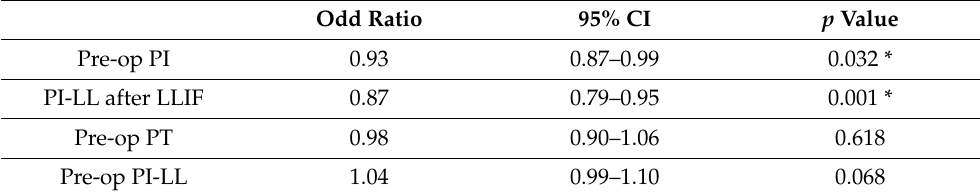
Table 5. Postoperative PI-LL > 10 ◦ risk factors (logistic regression analysis).